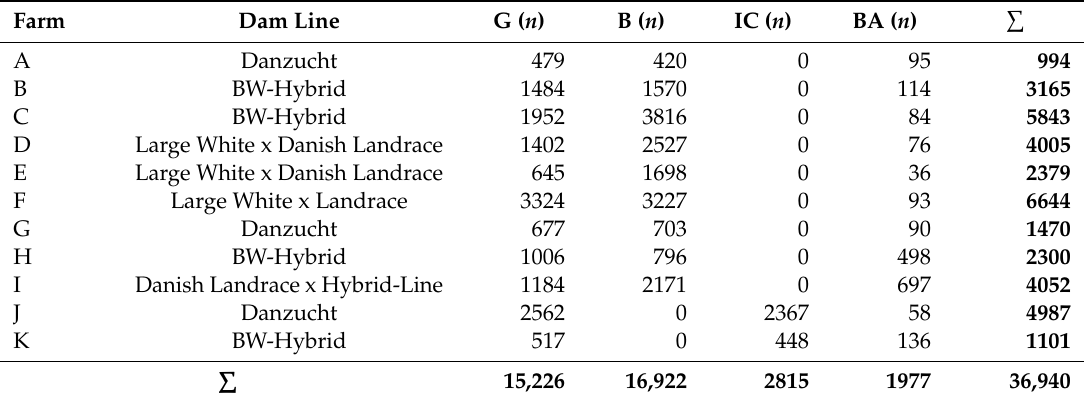
Table 1. Dam line and number of pigs per sex group (gilts (G), boars (B), immunocastrates (IC) and barrows (BA)) from 11 farms in Baden-Württemberg (Germany) slaughtered on Tuesdays from January 2018 to June 2019 at the slaughterhouse of Vion Crailsheim GmbH (Germany) at a hot carcass weight between 50 and 120